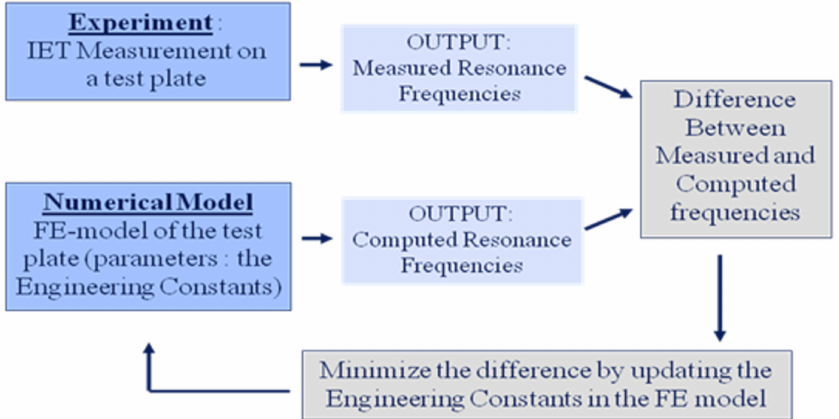
Figure 2. Mixed numerical experimental method: iteratively updating the engineering constants in the numerical finite element (FE) model of a test